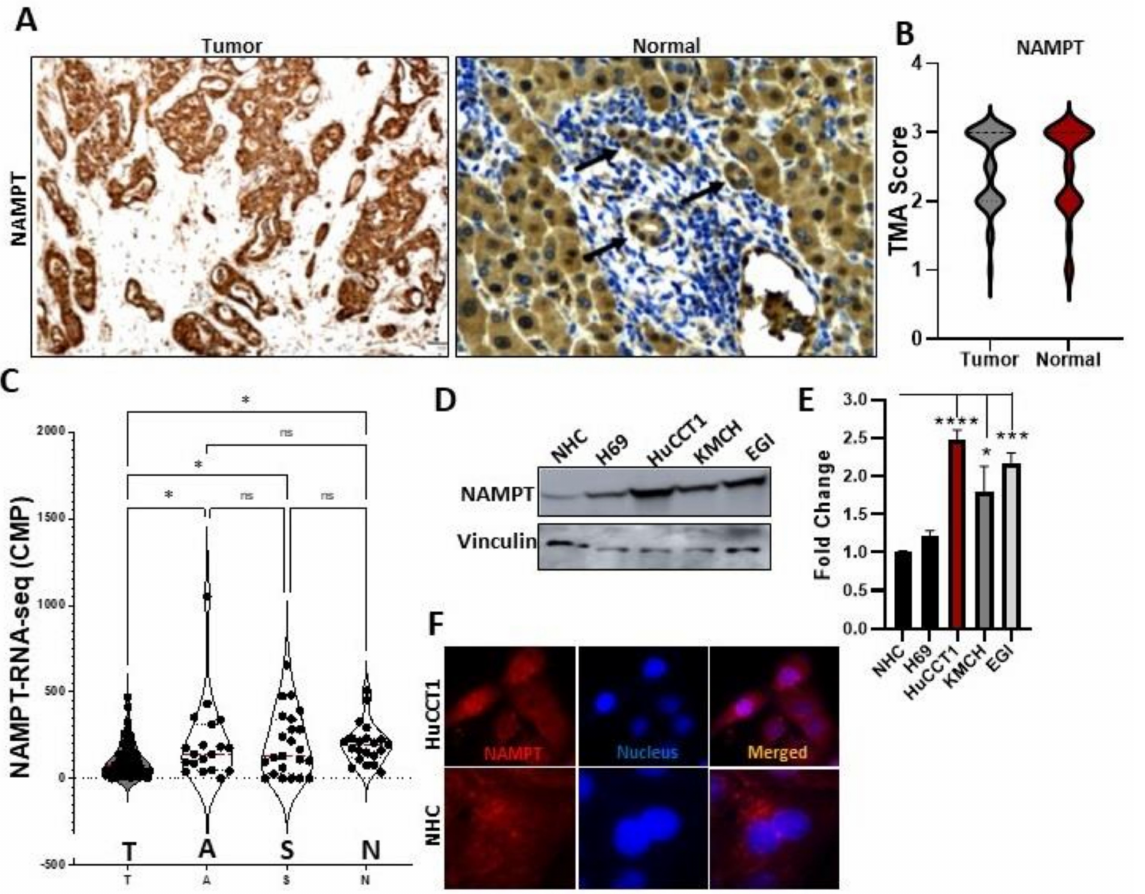
Figure 1. NAMPT expression in CCA cells. ( A ) On TMA slides, IHC for NAMPT in the CCA tumor was compared with the surrounding healthy tissue. ( B ) IHC scoring was performed for assessing NAMPT expression in tumors and normal bile duct. ( C ) RNA-seq analysis of the NAMPT gene in an independent cohort of CCA patients, where T —Tumor, S —surrounding stroma, and N —normal area. ( D , E ) NAMPT expression was analyzed in NHC, H69, HuCCT1, KMCH, and EGI cells with Western blotting technique and densitometry analysis was performed. ( F ) NAMPT immunofluorescence was conducted in the NHC and HuCCT1 cells (* p < 0.05, *** p < 0.001, **** p < 0.0001 and ns,